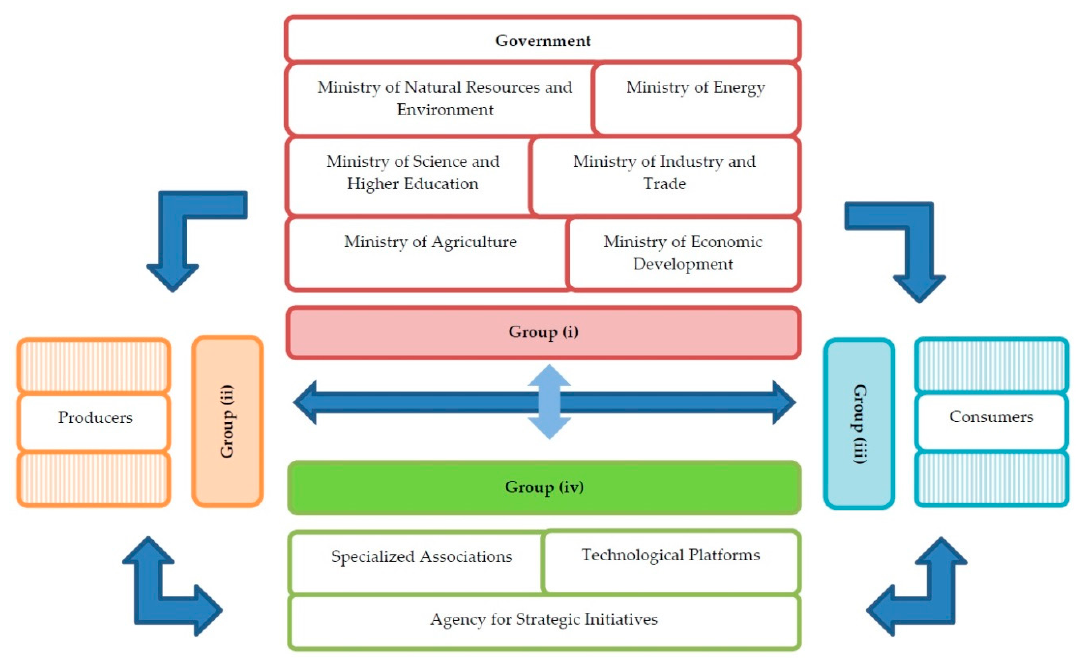
Figure 4. The general scheme of relations between the four groups of the BF market participants group (i) [89–92]; group (ii) [93,94]; group (iii) [94–96]; group (iv) [97–101].